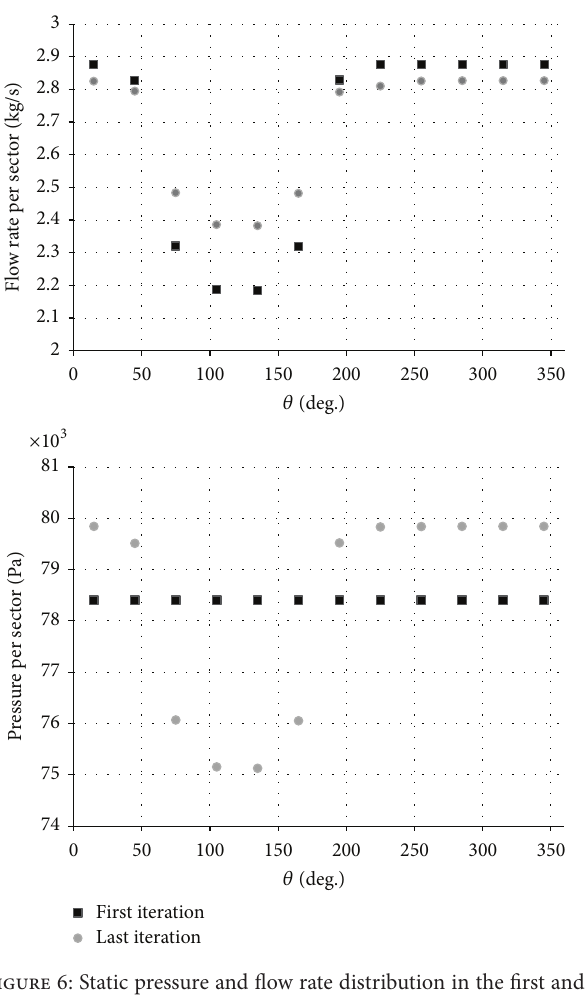
Figure 6: Static pressure and flow rate distribution in the first and last iterations.